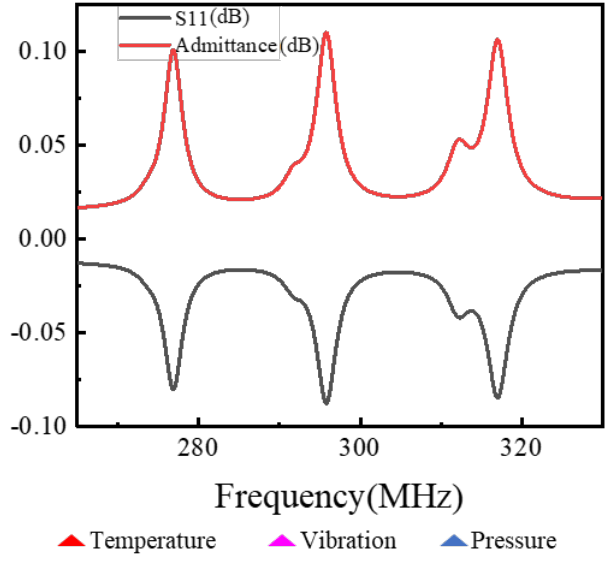
Figure 10. Three-parameter simulation design drawing.